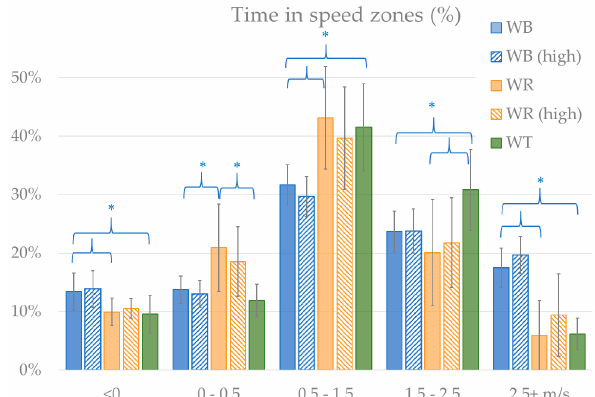
Figure 4. Distribution of time spent in speed zones, with significant (p < 0.05) differences marked with *. In rotational speeds, differences between distribution in zones were less prominent, despite the fact that some differences between sports were still quite statistically significant (p < 0.05; Figure 5). The one clear deviation was the additional time of wheelchair rugby players in the lowest zone and the reduced time in the 100+ °/s zone.